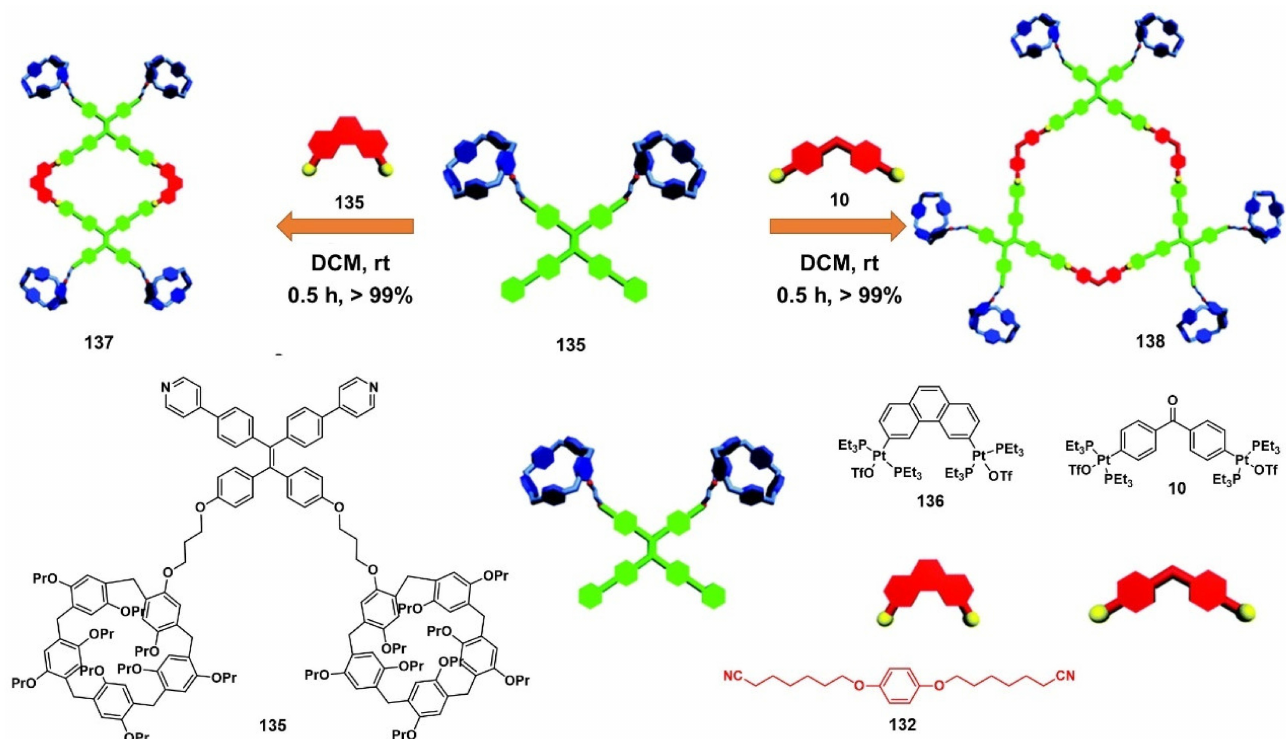
Figure 54. Graphical representation of the self-assembled metallacycles 137 and 138 . Reprinted with permission from Ref. [136]. Copyright (2018), Royal Society of